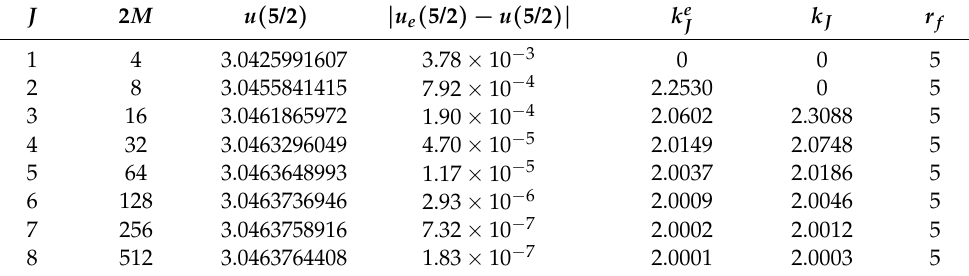
Table 9. Solutions to (25) where u e ( 1/2 ) = 3.046376624 using HWM.